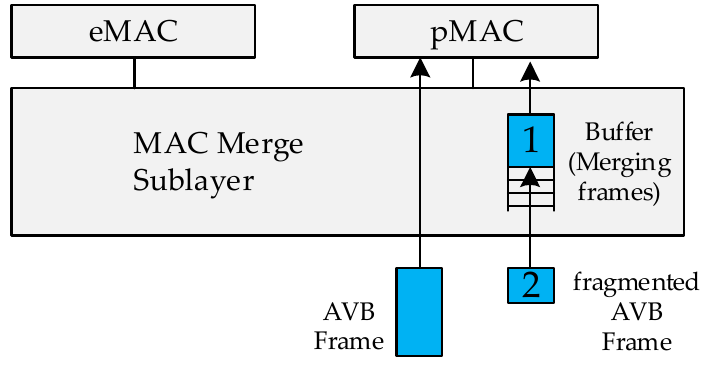
Figure 3 . Receiver side MAC merge sublayer structure.